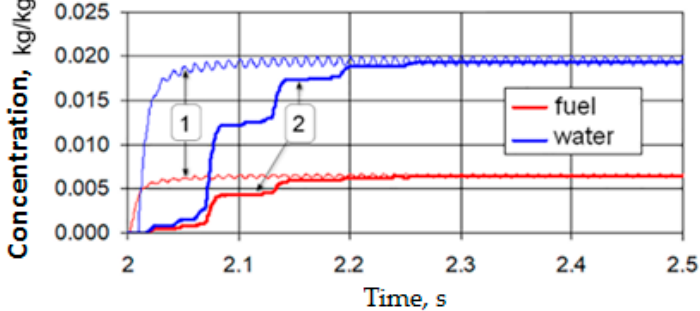
Figure 6. Dynamics of changes in the concentration of vapors of fuel and water at the installation site of the injectors (1) and the inlet channel of the head of the 1st cylinder (2) of the gas-air duct. (Source: Authors).